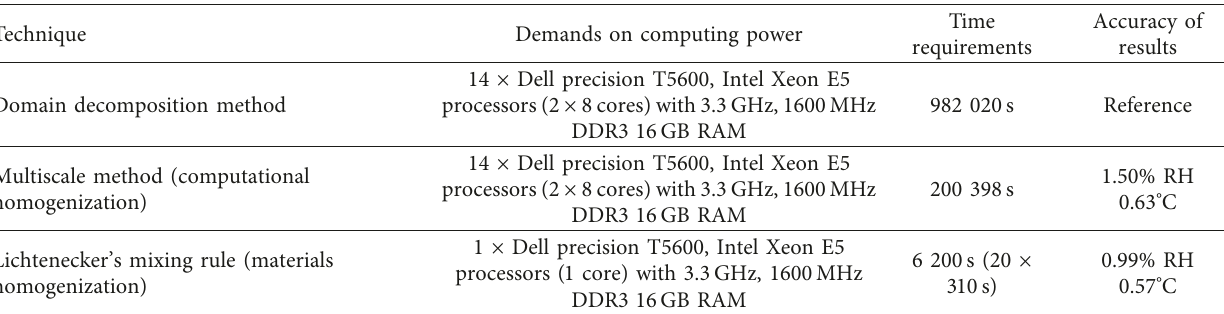
Table 3: Summary of